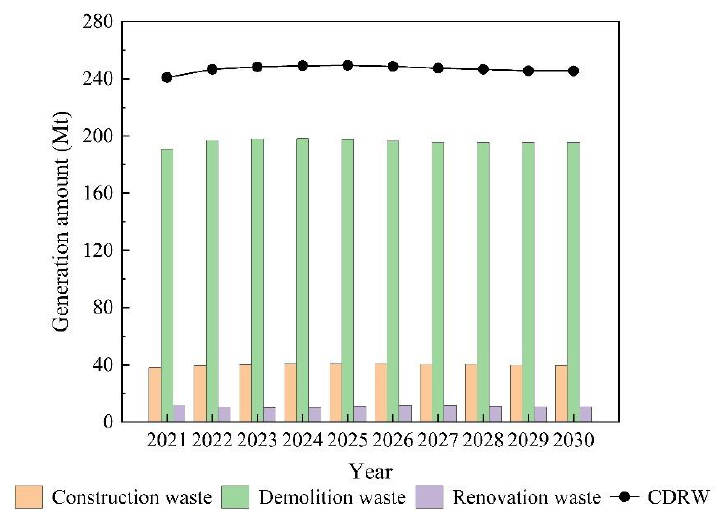
Figure 6. Prediction of annual CDRW generation in Jiangsu Province from 2021 to 2030.